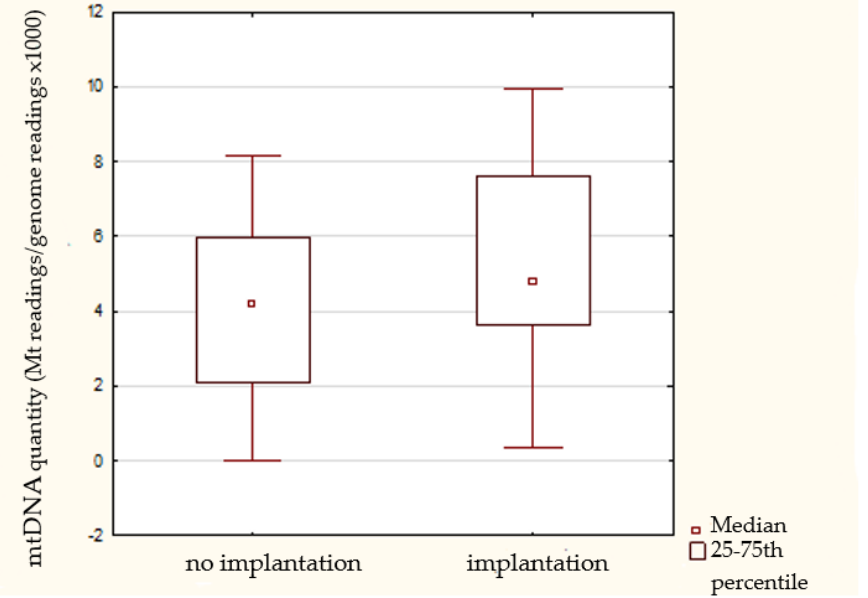
Figure 3. Boxplot (median, hinges: first and third quartiles) showing mtDNA/gDNA ratios obtained for implanted and non-implanted groups of transferred embryos. NGS analysis of 62 transferred embryos showed no significant difference in the quantity of mtDNA between implanted and non- implanted embryos.